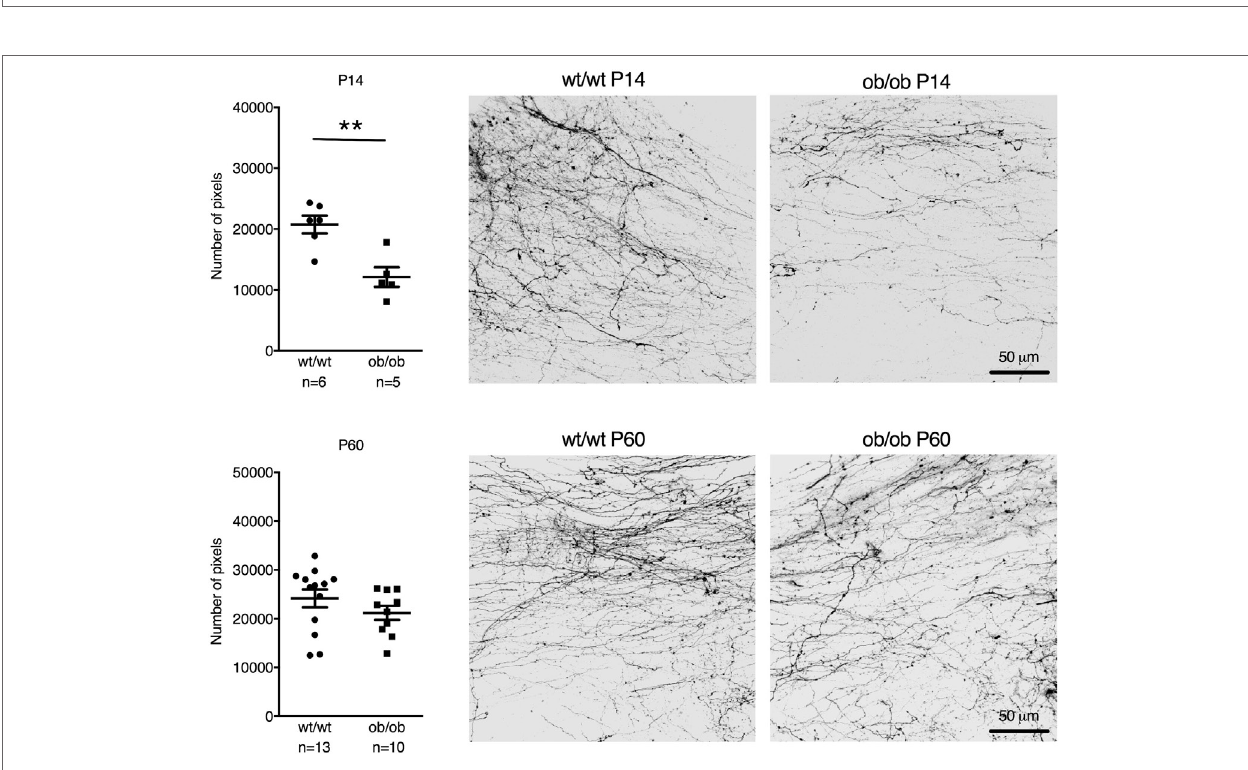
FigUre 2 | Quantification and representative images of DiI staining of area postrema–NTS projections in P10 (upper panel) and P60 (lower panel) IAPP + / + wild-type and amylin-deficient IAPP − / − mice. Amylin deficiency resulted in reduced fiber densities at both time points compared to controls (* p < 0.05, Student’s t -test).